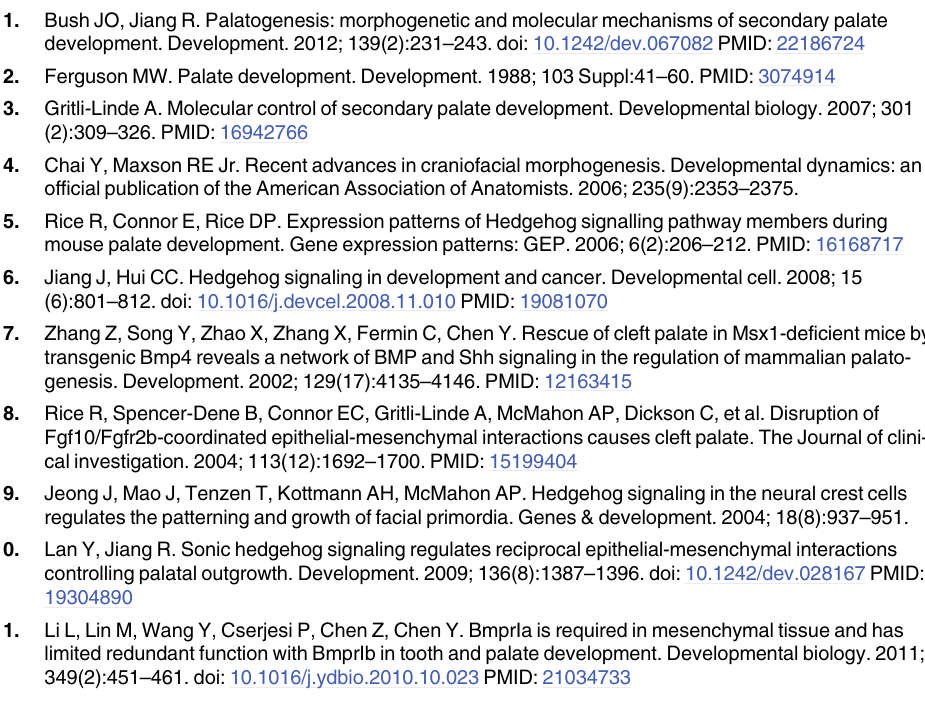
S4 Fig. Comparison of expression of Fgf18 mRNAs in Foxf1 c/c Foxf2 c/c and Foxf1 c/c Foxf2 c/c Wnt1-Cre mutant embryos. Frontal sections showing expression of Fgf18 mRNA in the anterior (A, B), middle (C, D) and posterior (E, F) regions of the developing palate in Foxf1 c/c Foxf2 c/c (A, C, E) and Foxf1 c/c Foxf2 c/c Wnt1-Cre mutant (B, D, F) embryos at E12.5. p, palatal shelf. (TIF) S5 Fig. Comparison of Shox2 and Barx1 mRNA expression patterns in Foxf1 c/c Foxf2 c/c and Foxf1 c/c Foxf2 c/c Wnt1-Cre mutant embryos. (A-D) Whole-mount in situ hybridization detection of Shox2 mRNAs in the developing palatal shelves in Foxf1 c/c Foxf2 c/c (A, C) and Foxf1 c/c Foxf2 c/c Wnt1-Cre mutant (B, D) embryos at E12.5 (A, B) and E13.5 (C, D). (E-H) Whole-mount in situ hybridization detection of Barx1 mRNAs in the developing palatal shelves in Foxf1 c/c Foxf2 c/c (E, G) and Foxf1 c/c Foxf2 c/c Wnt1-Cre mutant (F, H) embryos at E12.5 (E, F) and E13.5 (G, H).